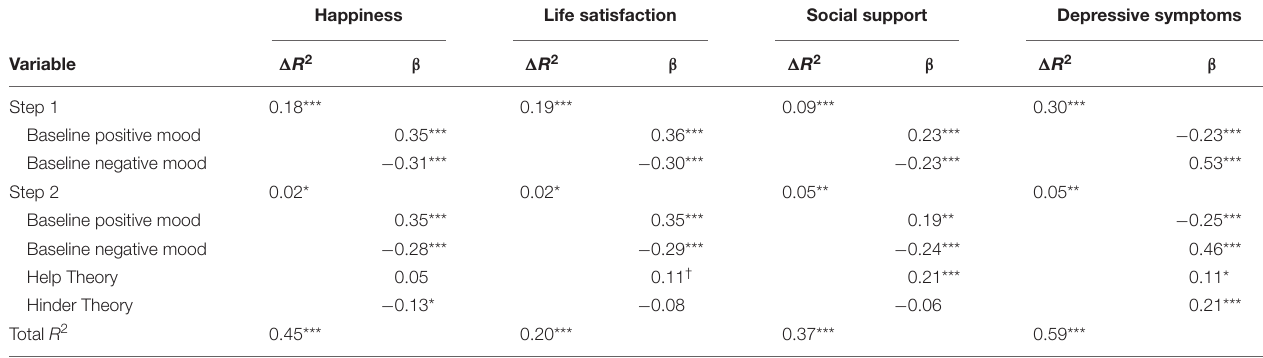
TABLE 4 | Study 1 summary of hierarchical regression analyses for Help and Hinder Theory endorsement predicting wellbeing outcomes ( N = 282). Happiness Life satisfaction Social support Depressive